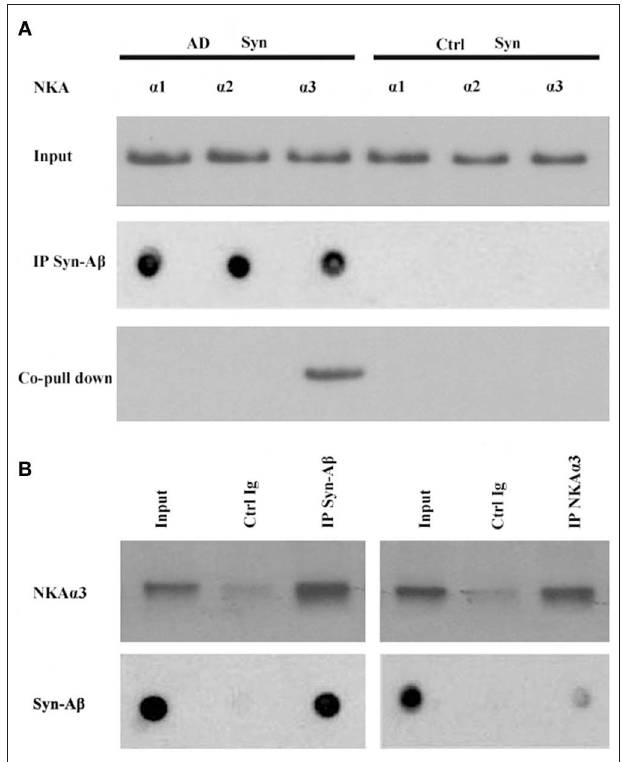
FIGURE 6 | Co-IP of synaptic β -amyloid peptides and NKA α 3 by A β O-antibody or NKA α 3-antibody. RIPA buffer extracts of synaptosomes from human AD and control frontal cortex were incubated with magnetic beads cosslinked to antibody for A β Os or for NKA α 3. Proteins released from beads were analyzed for NKA α 1, α 2, α 3 isoforms by Western blot or for β -amyloid peptides by dot blot with 6E10. (A) A β O-antibody pulled down A β (dot blot) and NKA α 3 (Western blot) from AD but not control synaptosome extracts. (B) Left panel: A β O antibody pulled down NKA α 3 (Western blot) and A β peptides (dot blot) from human AD synaptosome. Negative control was carried out with magnetic beads coupled to non-specific IgG. Right panel: NAK α 3 antibody pulled down NKA α 3 (Western blot) and A β peptides (dot blot) from human AD synaptosome. Negative control carried out with non-specific IgG. Results show that NKA α 3 complexes containing A β Os were present in AD but not control brain synaptosome and could be pulled down by co-IP.